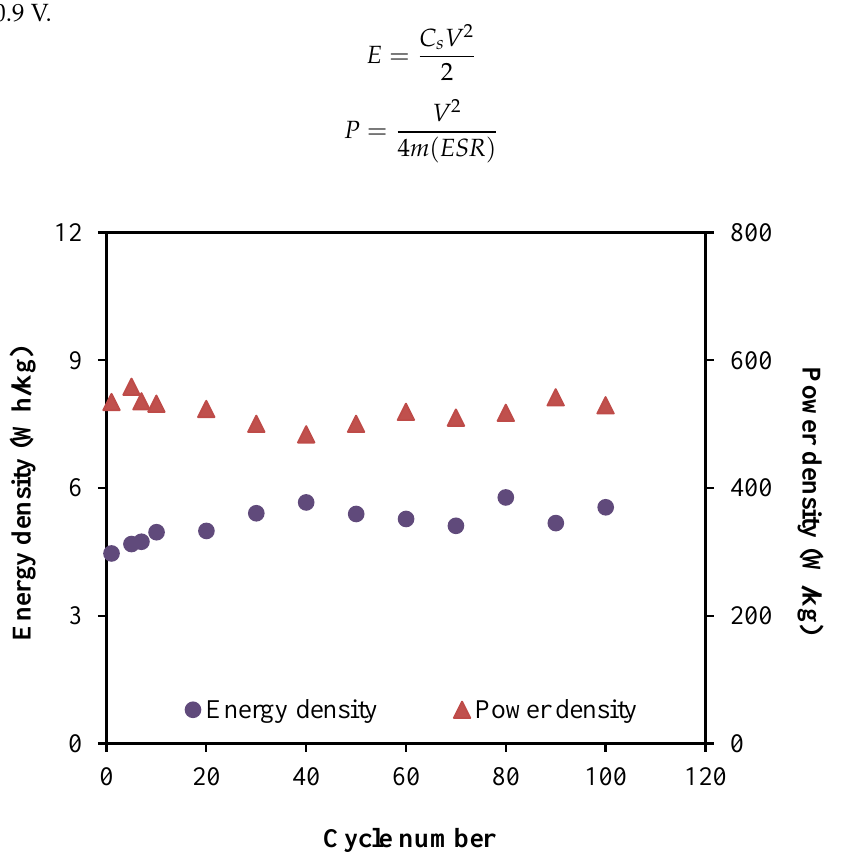
Figure 13. Energy density and power density of the fabricated EDLC.